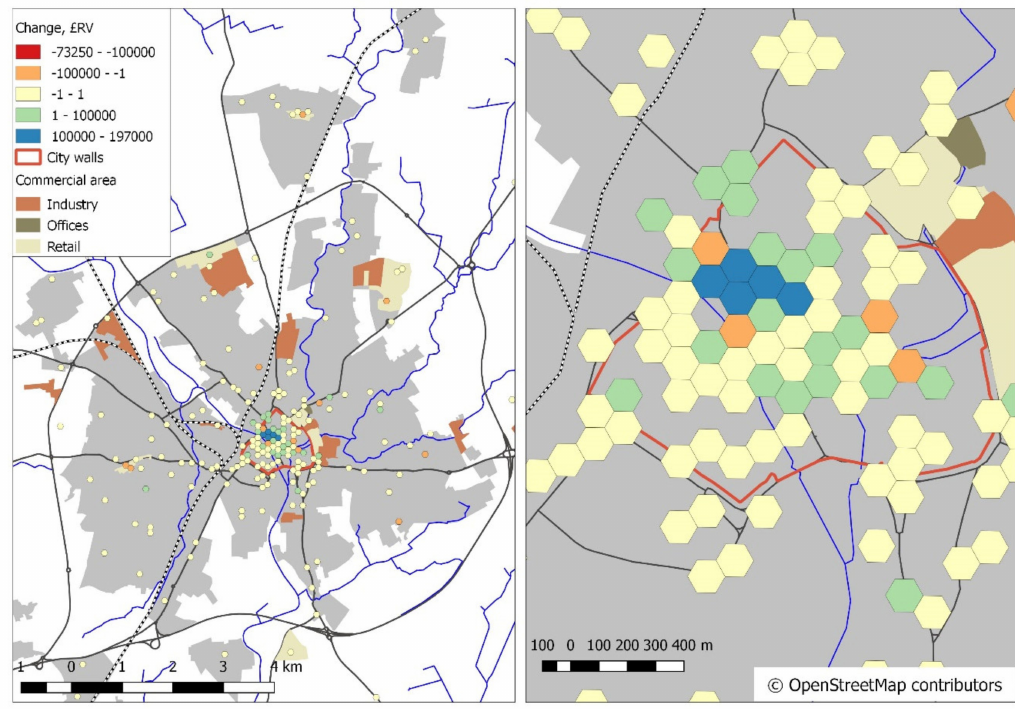
Figure 14. Change in food and drink RV,